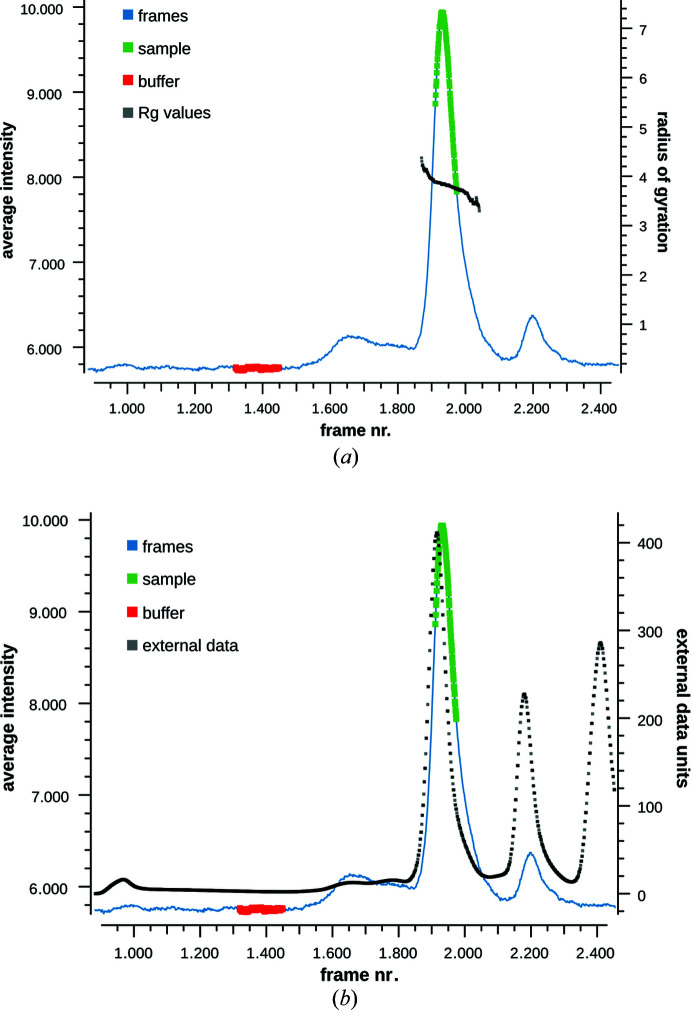

CHROMIXS updates. (a) Regions in the SEC-SAS data (blue line) which represent the sample (green, on the peak) and buffer (red, on the flat region) can be selected manually or automatically. The R
g or MW across the sample region (black correlation, through the sample elution peak) can be calculated. (b) Complementary time-course data (black dots), such as a UV absorbance trace to track protein elution, can be loaded and viewed together with the SEC-SAS data. The third (rightmost) UV absorbance peak corresponds to buffer mismatch, i.e. components in the sample buffer that are not present in the SEC running buffer.